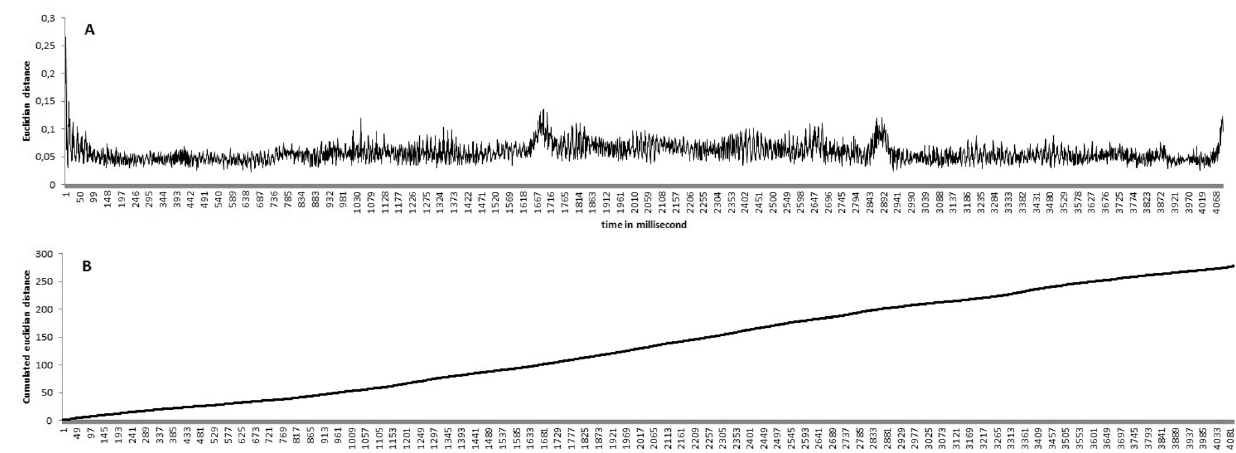
Figure 3. Illustration of ( A ) Euclidean distance and ( B ) cumulative Euclidean distance for each